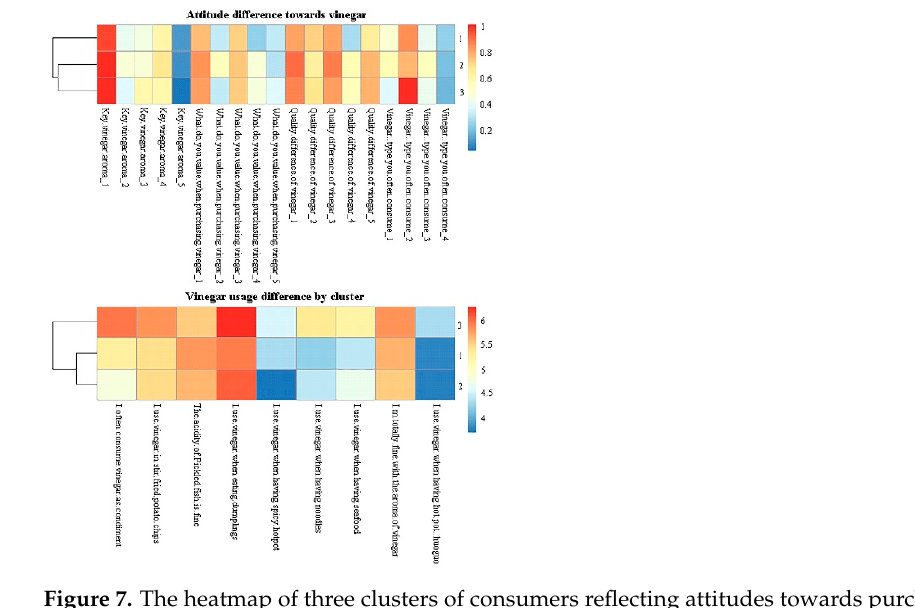
Figure 7. The heatmap of three clusters of consumers reflecting attitudes towards purchasing and using vinegar (n = 30 for cluster 1, n = 18 for cluster 2 and n = 28 for cluster 3).